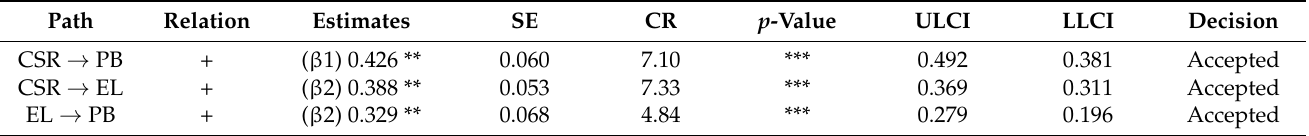
Table 5. The results for hypotheses (H1, H2, and H3).